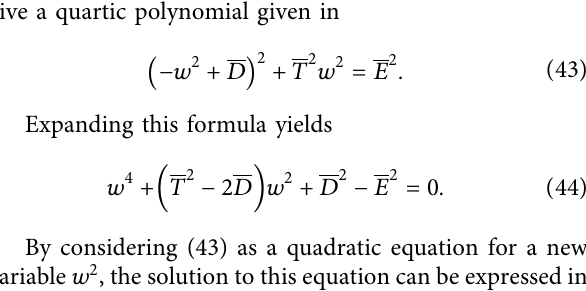
j Figure 2: The graph of F ( y ) and its value at the roots of G ( y ) , r positive